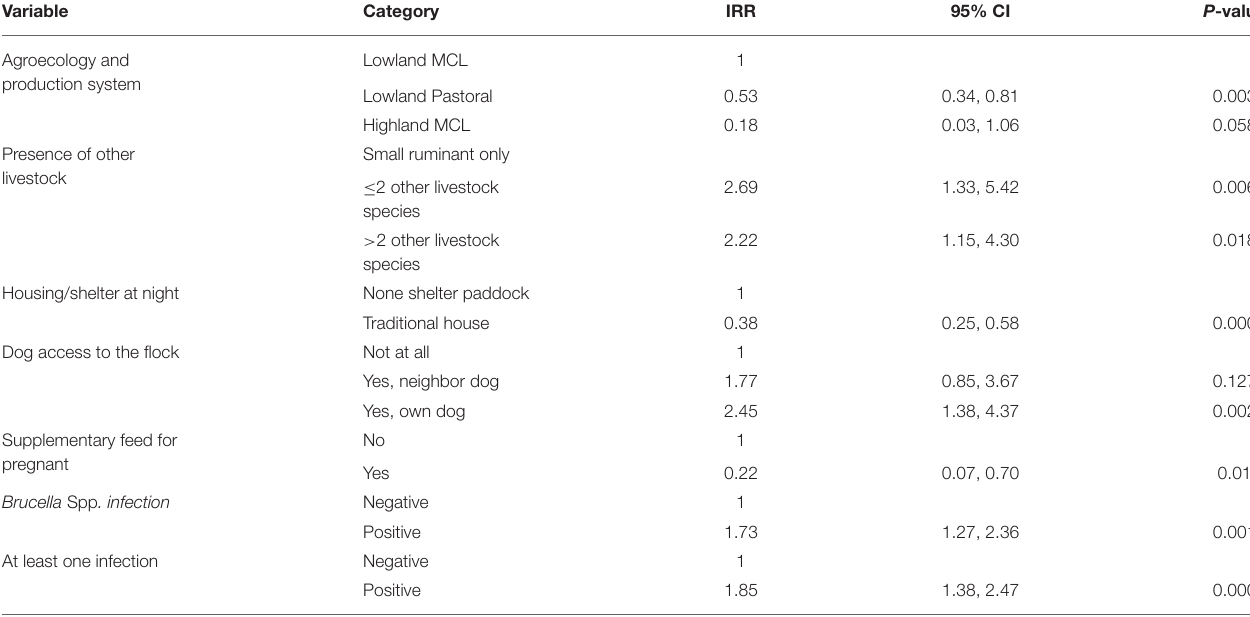
TABLE 6 | Final model of multivariable zero-inflated negative binomial regression analysis for effect of management and exposure to abortion pathogens on abortion in the